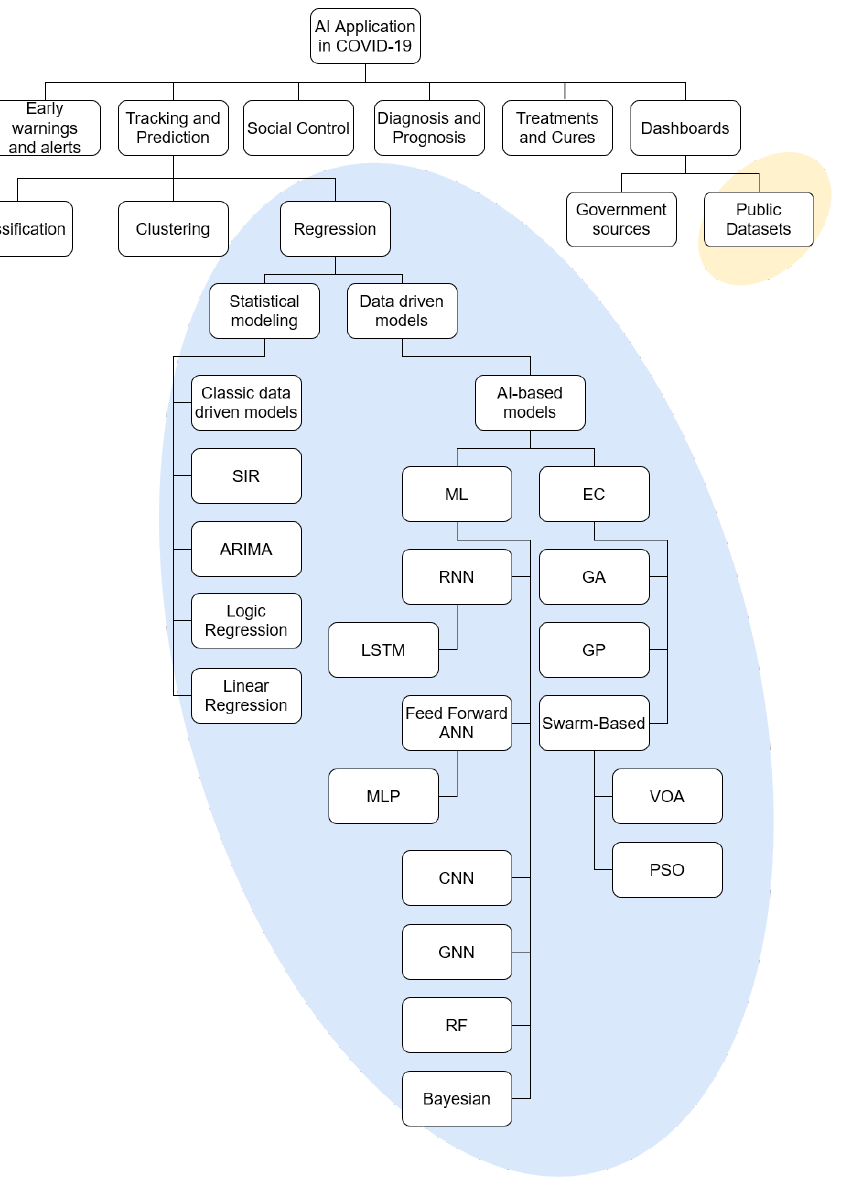
Figure 2. Taxonomy of the AI research in the field of COVID-19, with the research reviewed in this pa- per being marked with an ellipsis. SIR-Suspectible, Infectious or Recovered, ARIMA-Autoregressive Integrated Moving Average, RNN-Recurrent Neural Network, LSTM-Long Short-Term Memory, ANN-Artificial Neural Network, MLP-Multilayer Perceptron, CNN-Convolutional Neural Network, GNN-Graph Neural Network, RF-Random Forest, GA-Genetic Algorithm, GP-Genetic Programming, VOA-Virus Optimization Algorithm, PSO-Particle Swarm